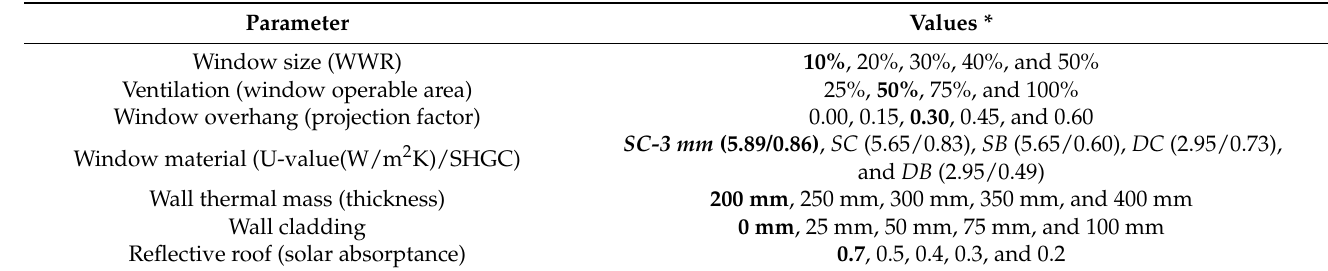
Table 2. The analyzed design features and their values.